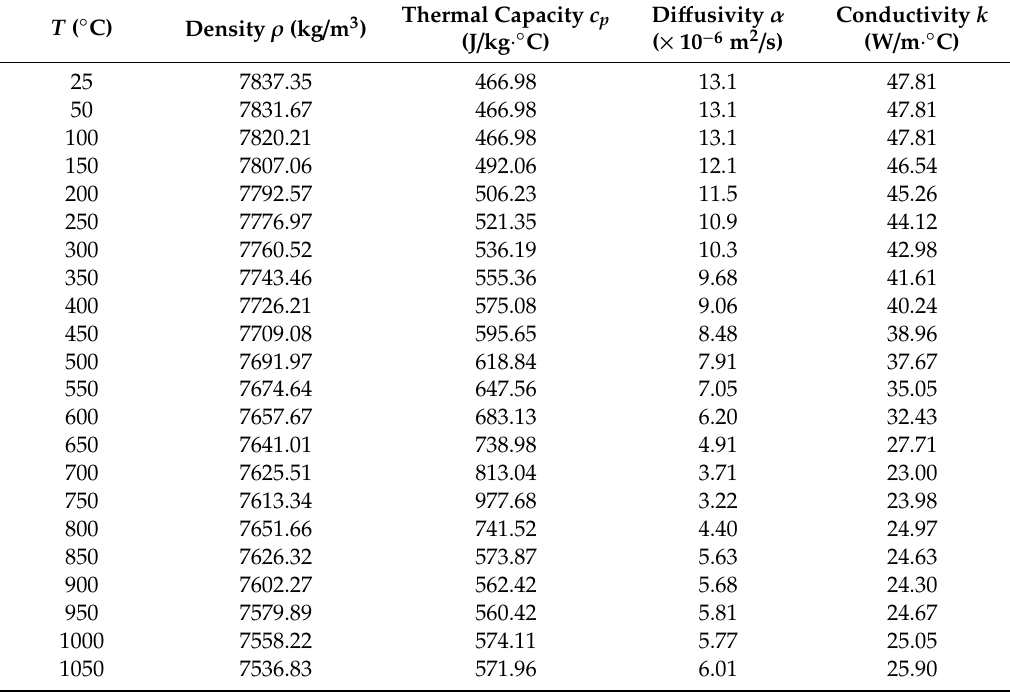
Table A3. Thermophysical properties for 42CrMo4 material measured on one substrate